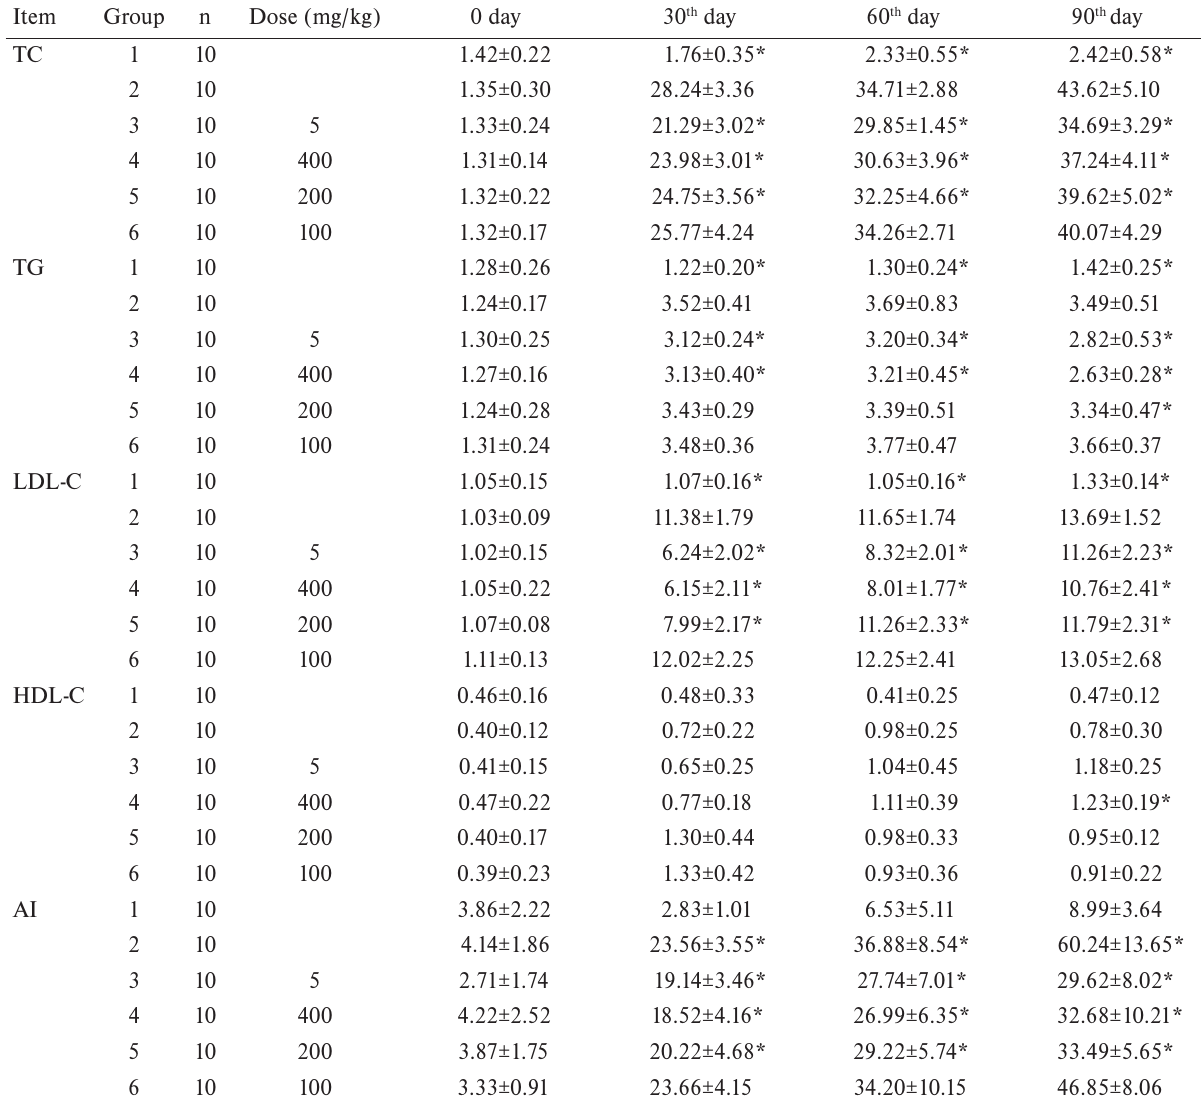
Table 1. Effects of puerarin on serum lipids (mmol/L, x ±